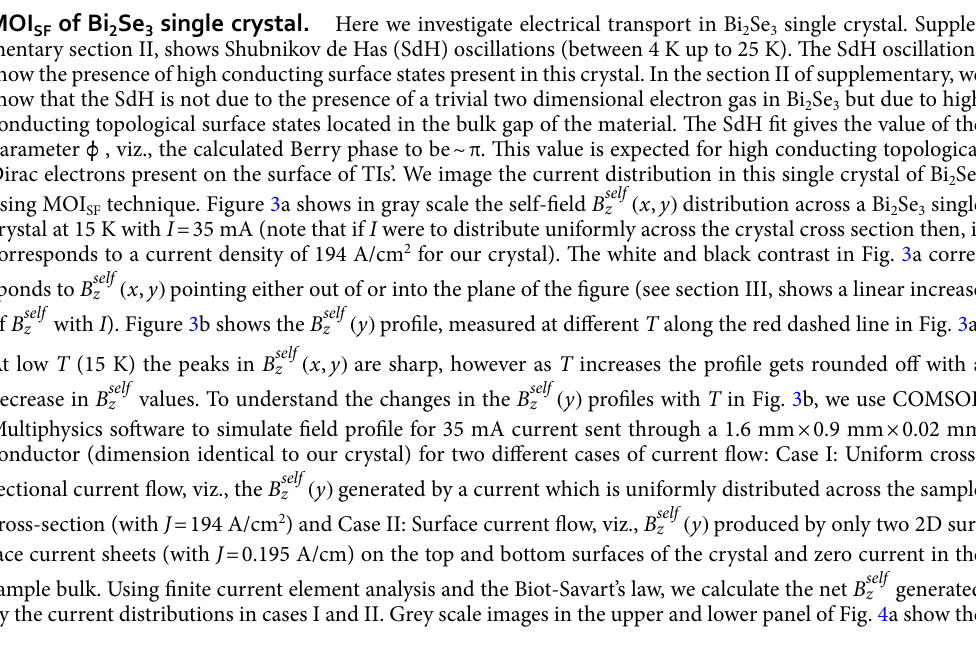
Figure 3. Imaging of the self-field distribution on Bi 2 Se 3 single crystal. ( a ) Figure shows self-field magneto optical image representing z - component of self-field in the ( x , y ) plane, viz, B green arrow represents the direction of the current ( I ) sent into the sample from the pads. ( b ) Figure shows B self z ( y ) measured along the red dashed line in Fig. 3a at 15 K, 70 K, 120 K, and 180 K. Inset figure shows the optical image of the Bi 2 Se 3 single crystal stuck on MgO